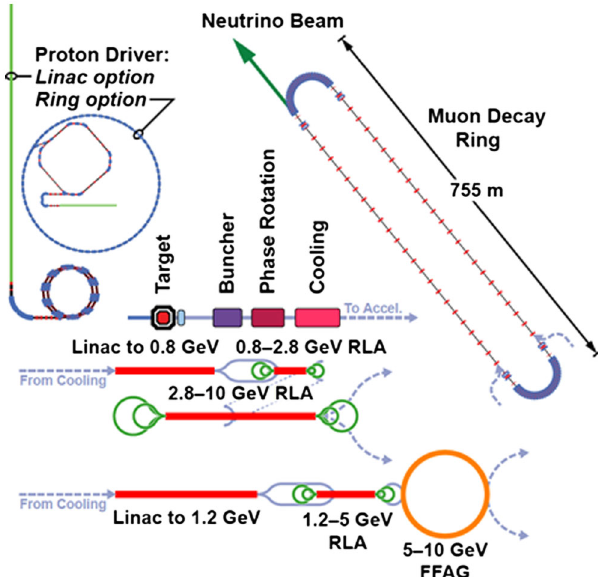
FIG. 12. Updated layout for a Neutrino Factory for 10 GeV operation, with only one decay ring. The two options for muon acceleration are